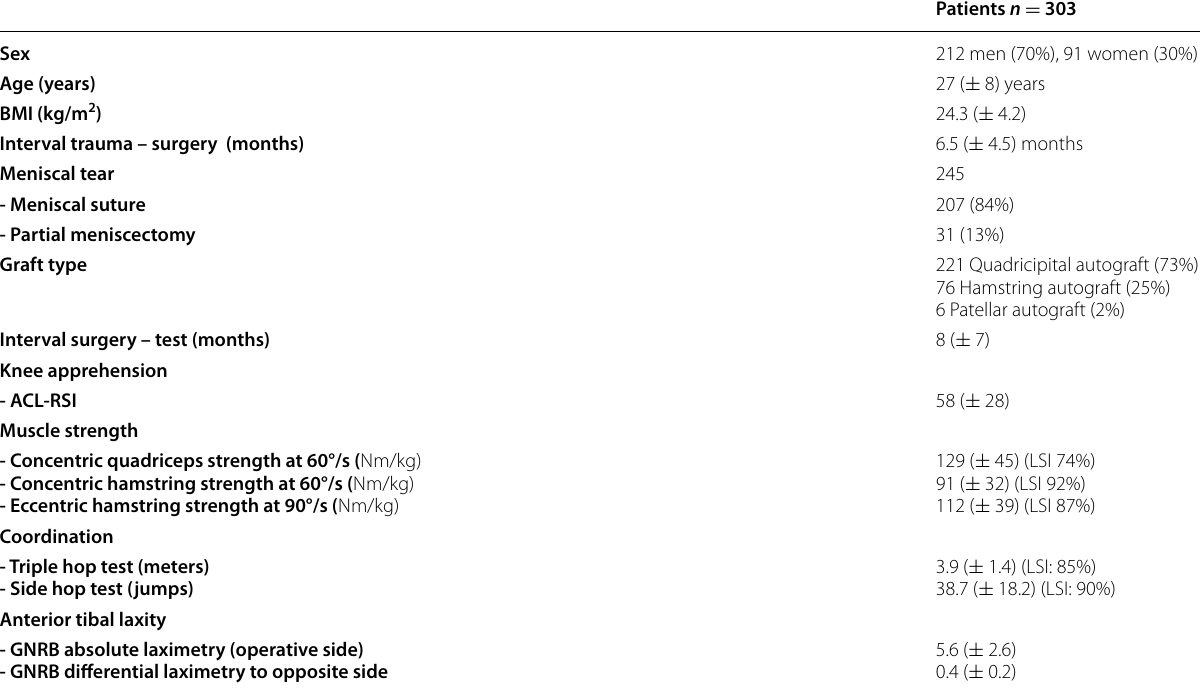
Table 1 ACL-RSI and sport testing battery after ACL reconstruction